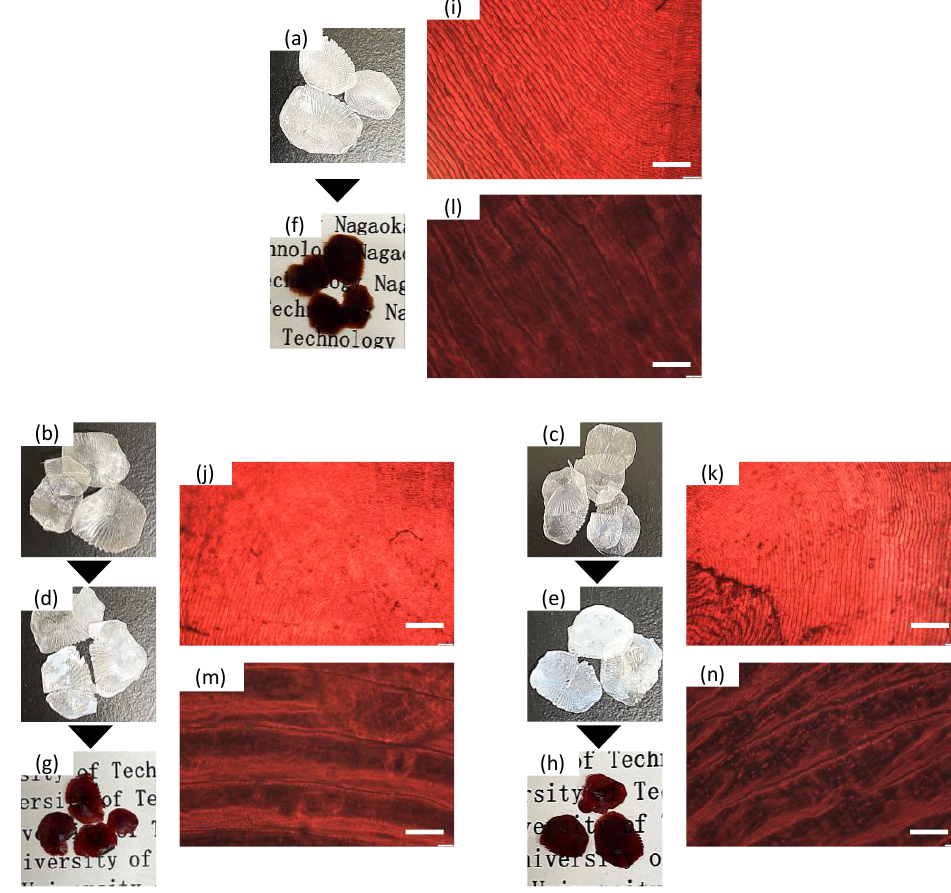
Figure 1. Representative photographs of ( a ) S, ( b ) DS- 0 SSBF, ( c ) DS-K- 0 SSBF, ( d ) DS- 72 SSBF, and ( e ) DS-K- 72 SSBF, and the Alizarin-red-S-stained ( f ) S, ( g ) DS- 72 SSBF and ( h ) DS-K- 72 SSBF and their optical microscope images of the stained ( i , l ) S, ( j , m ) DS- 72 SSBF and ( k , n ) DS-K- 72 SSBF with the scale bars of ( i – k ) 400 and ( l – n ) 40 μm.